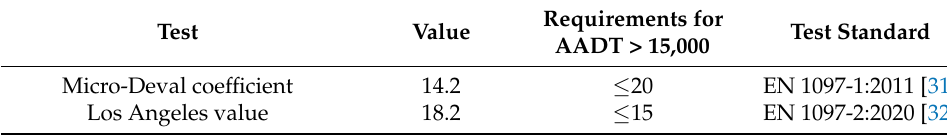
Table 2. Resistance to wear and fragmentation of crushed rock aggregates.